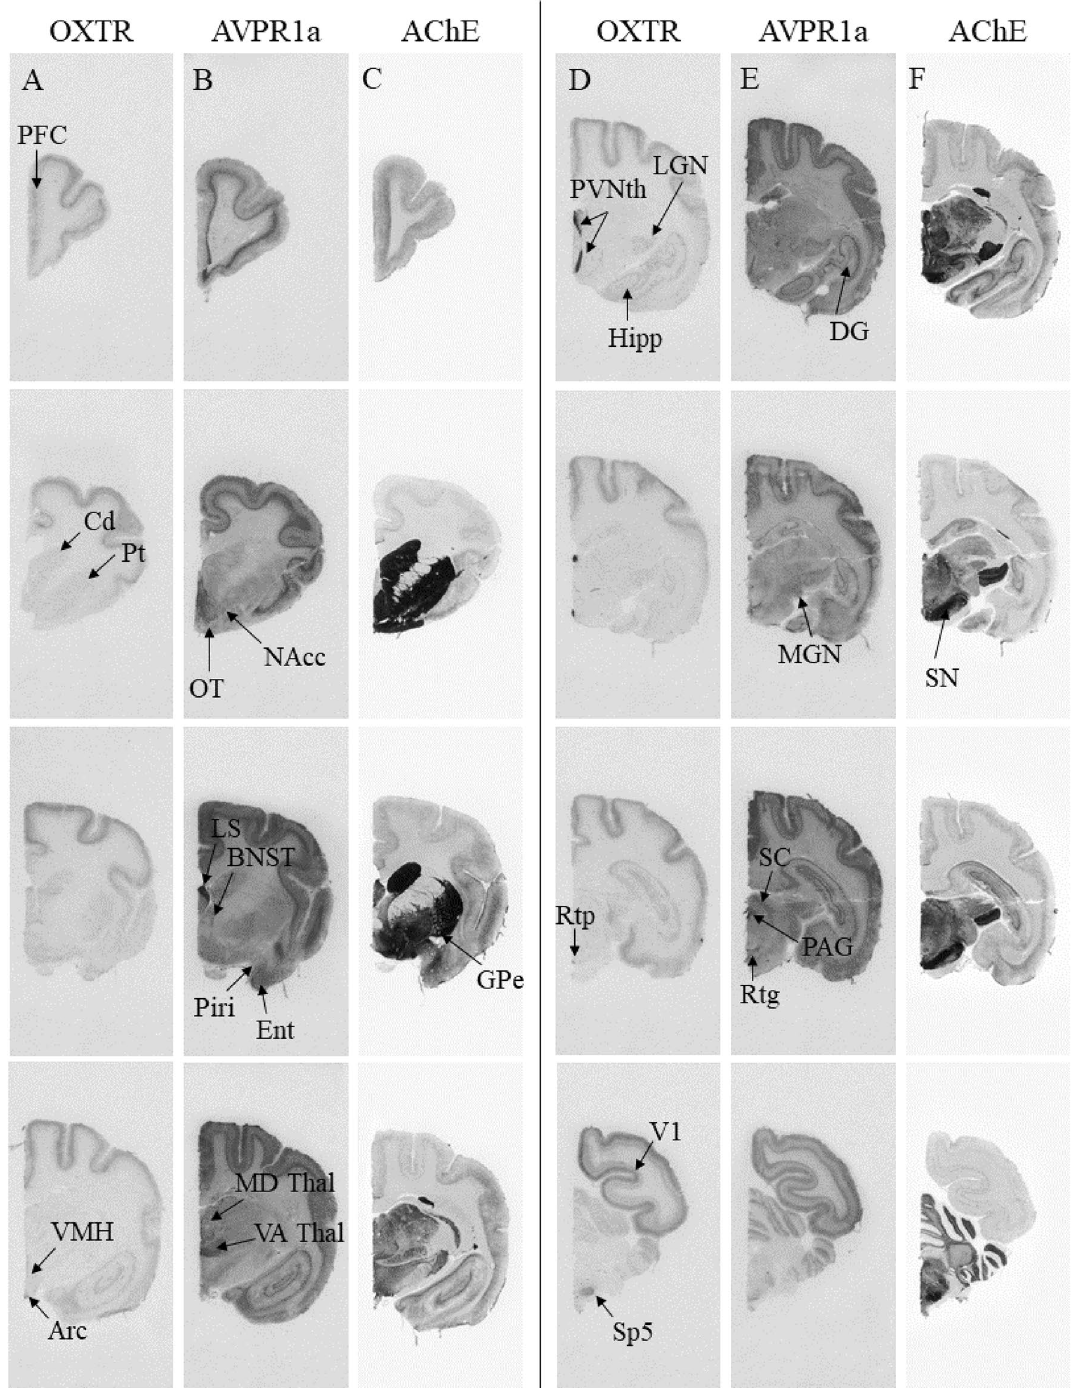
Figure 3. Distribution of OXTR ( A , D ) and AVPR1a ( B , E ) in sequential coronal sections from the brain of one representative monogamous Eulemur individual ( E. rubriventer) , aligned with acetylcholinesterase (AChE) counterstain ( C , F